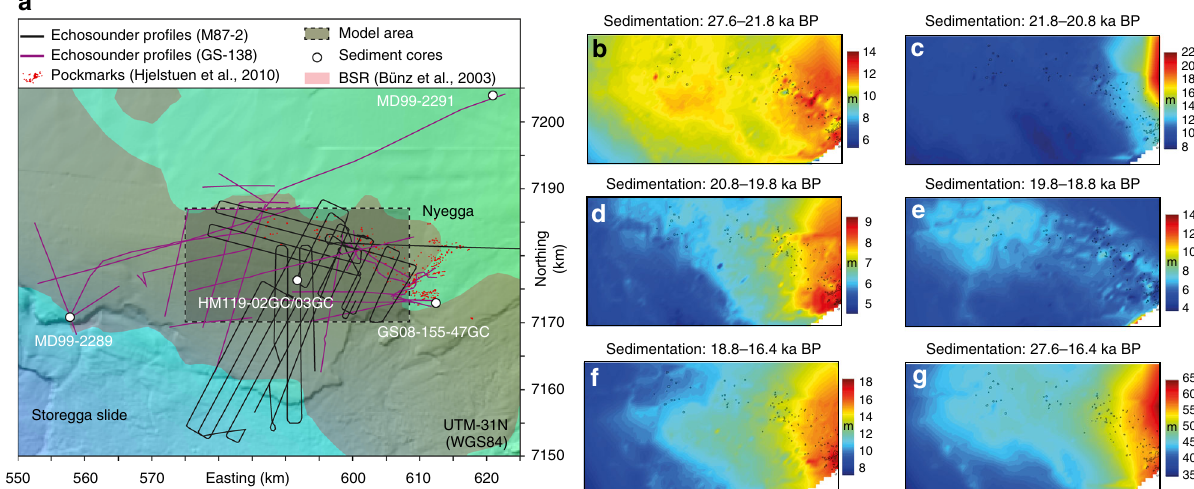
Fig. 6 Reconstruction of the seismo-stratigraphic framework of the Nyegga area. a Map showing the location of the echosounder pro fi les used for the seismo-stratigraphic framework, pockmarks, sediment core locations, model area, and area with mapped BSR (Bottom-simulating re fl ector).The map was created with IHS Kingdom Suite and data sourced from bathymetry grids created by Norsk Hydro AS 55 . b – g Sediment thickness maps for different intervals of the seismo-stratigraphic